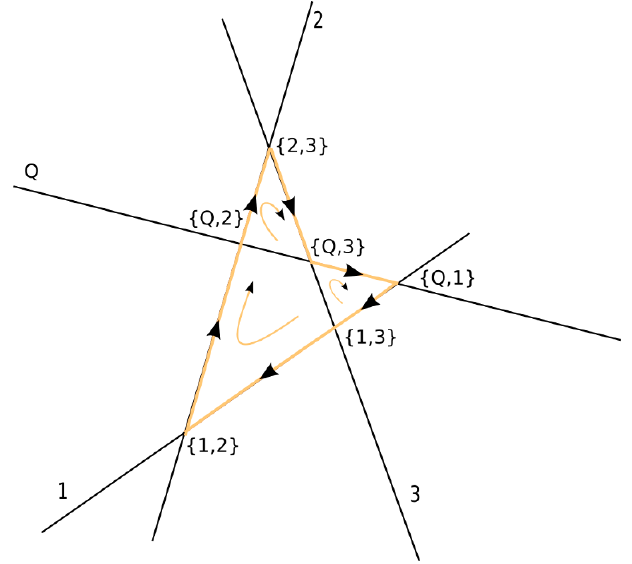
Figure 11 . The area de(cid:12)ned by the vertex object F 31